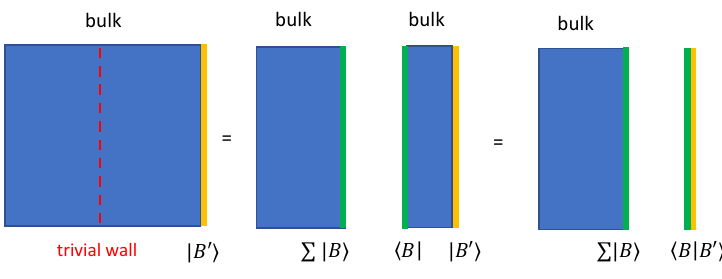
Figure 7 . Computation by inserting the trivial